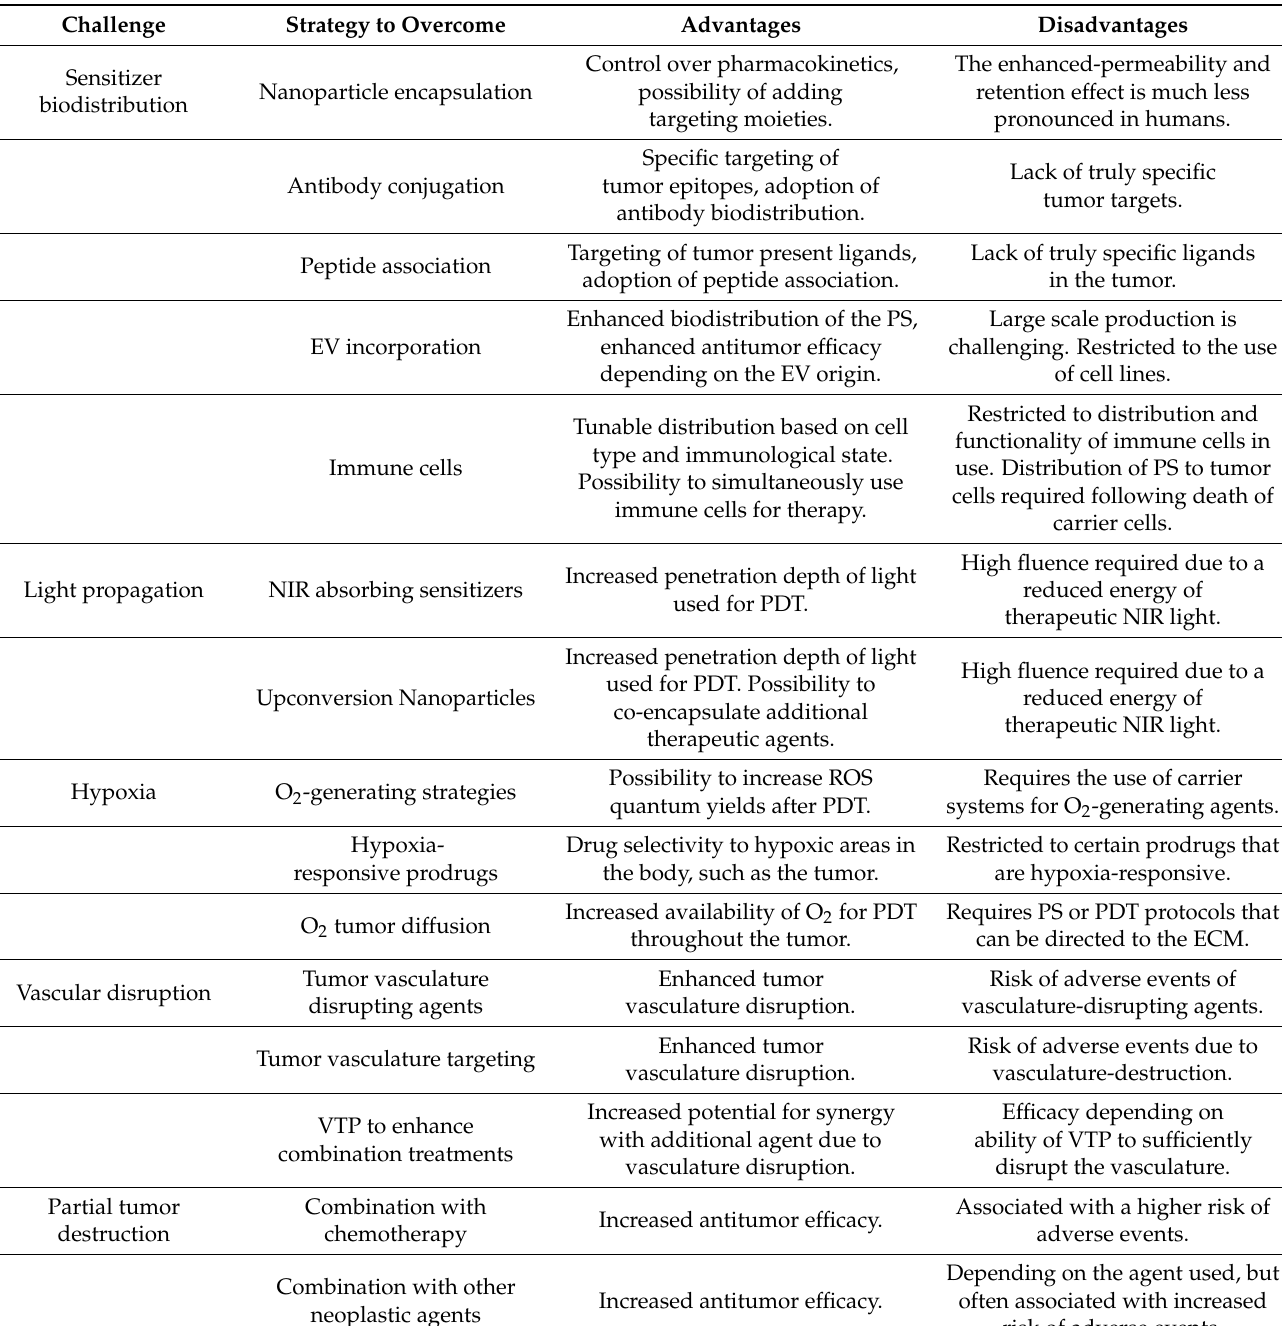
Table 2. Overview of the advantages and disadvantages for the current opportunities of